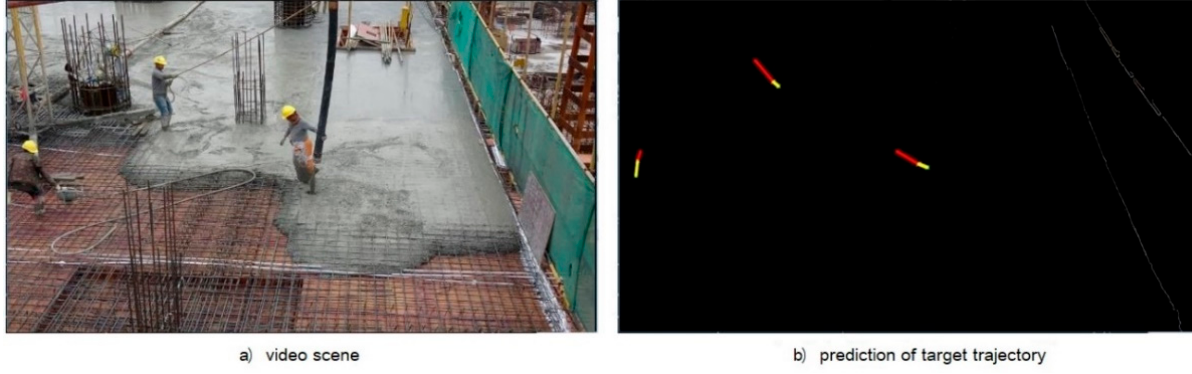
Figure 15. Positioning error.